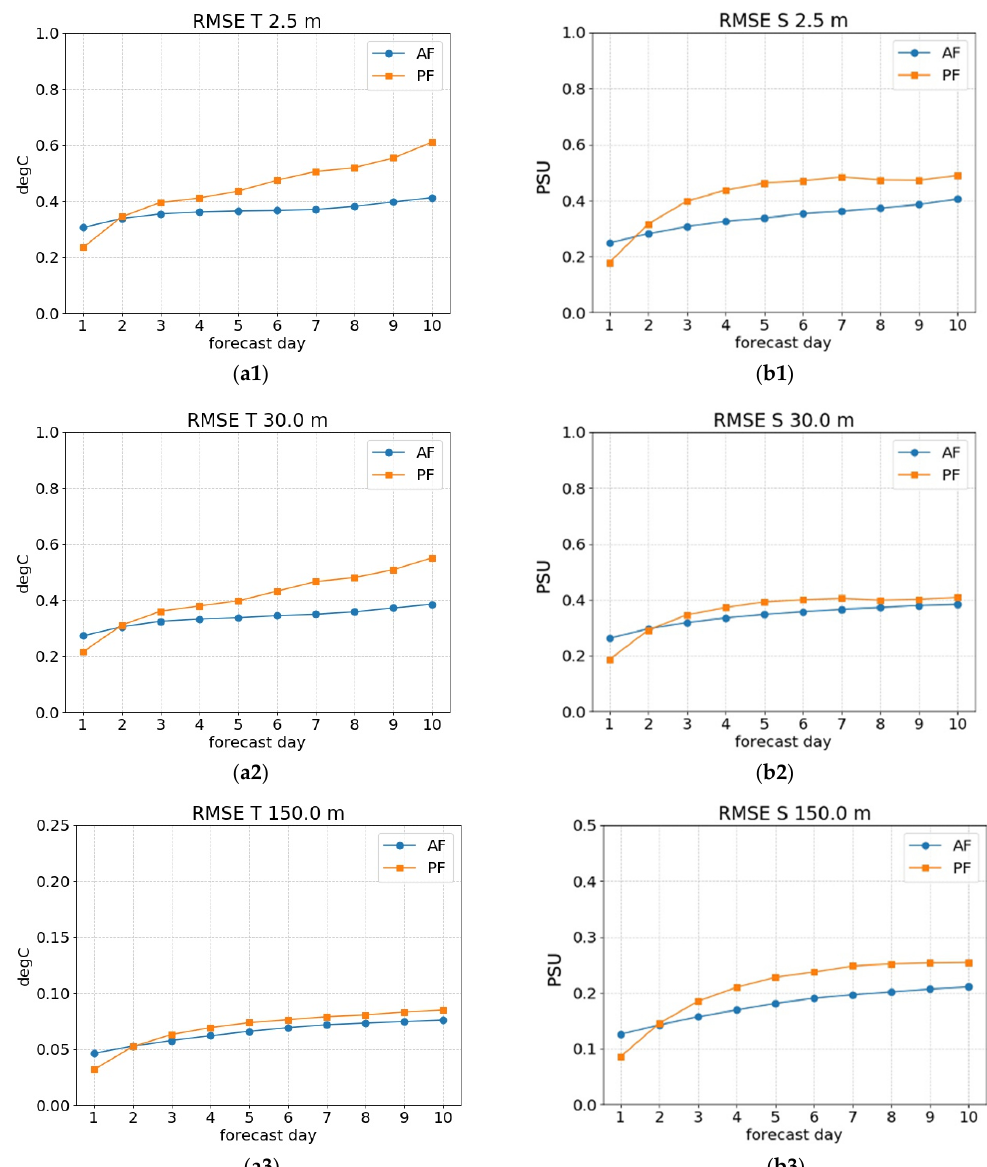
Figure 6. RMSE of 𝐴𝐹 (Analysis-Forecast, in blue), 𝑃𝐹 (Forecast-Persistence, in orange) for tem- Figure 6. RMSE of AF (Analysis-Forecast, in blue), PF (Forecast-Persistence, in orange) for tempera- perature (on the left, ( a1 – a3 ), expressed in °C) and salinity (on the right, ( b1 – b3 ), expressed in PSU) ture (on the left, ( a1 – a3 ), expressed in ◦ C) and salinity (on the right, ( b1 – b3 ), expressed in PSU) at at 2.5 m (1), 30.0 m (2) and 150 m (3), computed for February 2020. 2.5 m (1), 30.0 m (2) and 150 m (3), computed for February